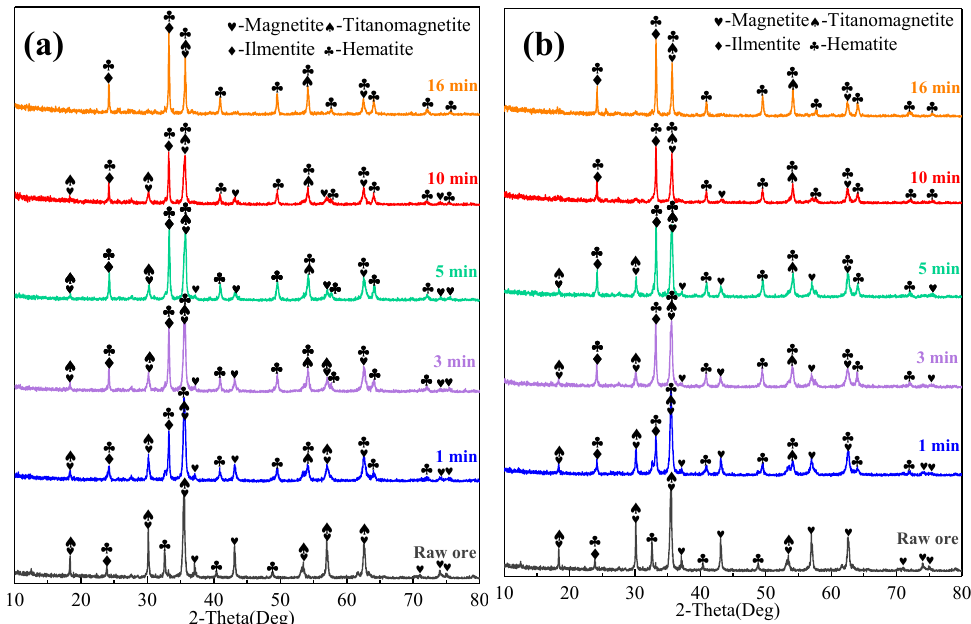
Figure 11. XRD patterns of pellets with the binders at different preheating times. ( a ) HB binder; ( b ) bentonite binder.